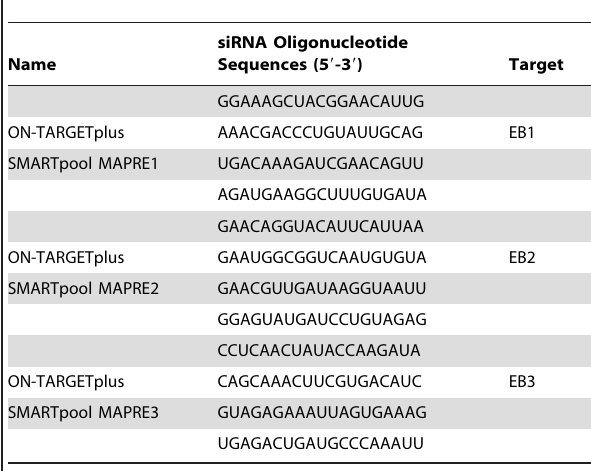
Table 2 summarises the sequences for the ON-TARGETplusSMARTpool siRNA oligonucleotides used in the si RNA transfection.